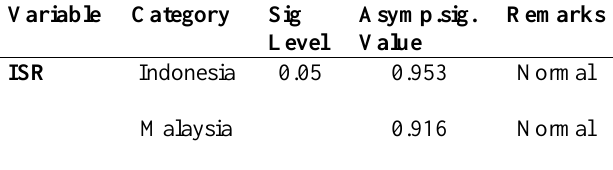
Table 2 Kolmogorov-Smirnov Normality Test